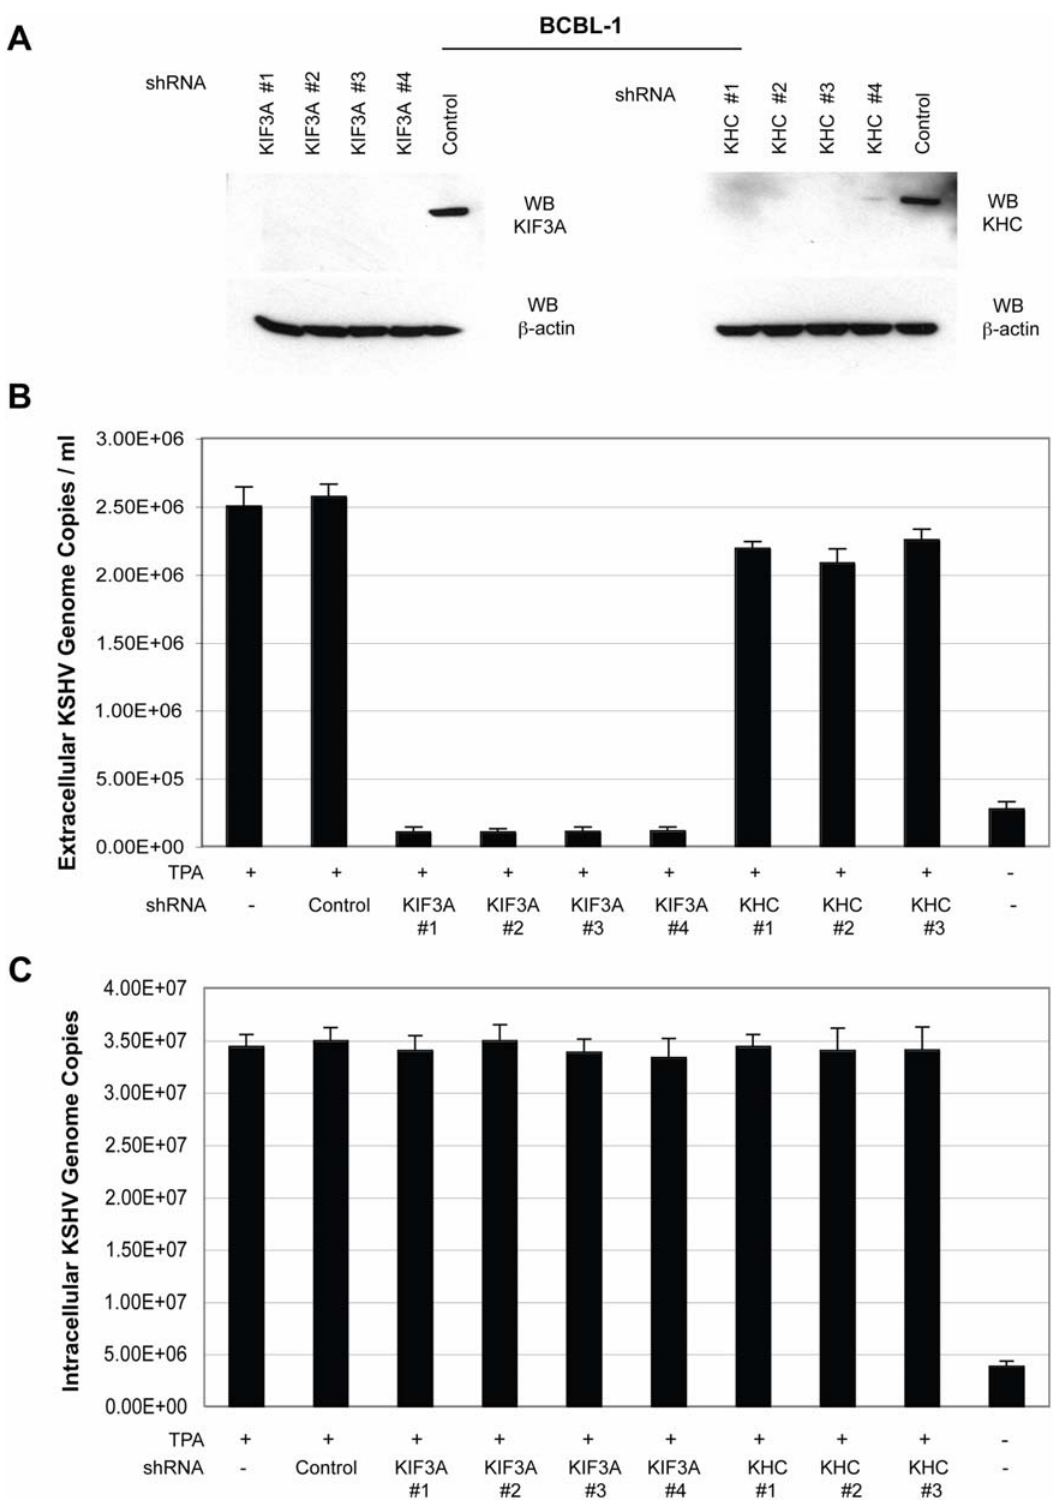
Figure 7. Knockdown of KIF3A and KHC by short-hairpin RNA (shRNA)–mediated silencing and the effects on KSHV egress and extracellular viral titers. (A) Inhibition efficiency of KIF3A and KHC expression in BCBL-1 cells. Two sets of shRNA constructs, each consisting of four individual shRNA lentiviral vectors in pLKO.1-puro plasmids against different target sites of KIF3A (KIF3A shRNA clone # s 1–4) and KHC (KHC shRNA clone # s 1–4), respectively, and a non-targeting control shRNA that activates the RNAi pathway without targeting any known human gene were introduced into BCBL-1 cells through lentiviral transduction in the presence of polybrene. Cells were selected through puromycin (2 m g/ml) selection for a week and then tested for effective knockdown of the respective proteins by a Western blot (WB) performed on the whole cell extracts using anti-KIF3A (rabbit-polyclonal, left panel) and KHC (rabbit-polyclonal, right panel). A WB for b -actin protein detection was also performed as an internal